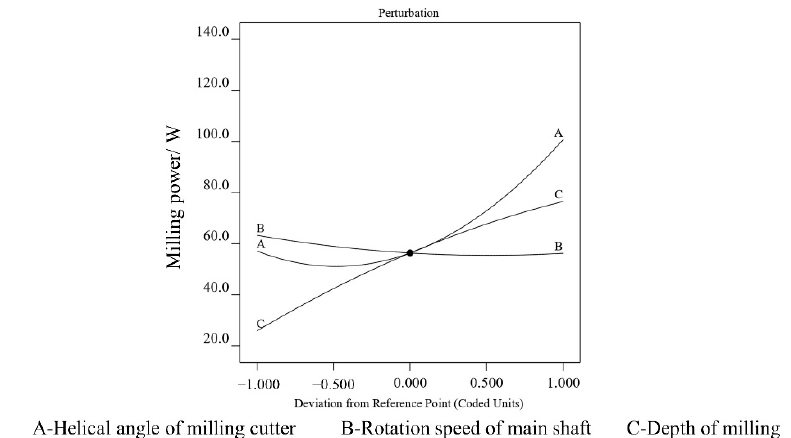
Figure 1. Influence trend chart for different input variables.